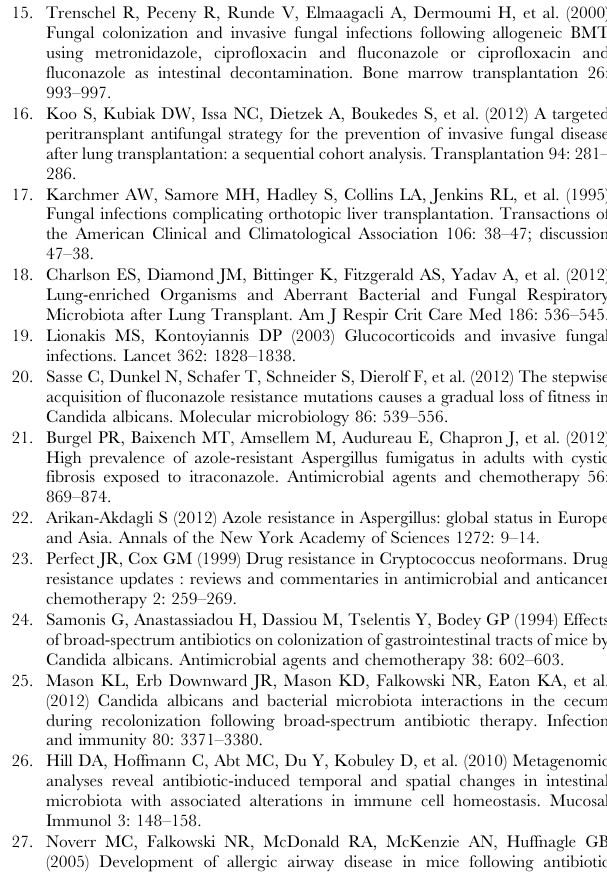
Table S4 Means, variances, and standard deviations for bacterial OTUs within treatment groups and time points rarefied to 200 reads per sample. Table S5 Means, variances, and standard deviations for fungal OTUs within treatment groups and time points rarefied to 200 reads per sample. Table S6 OTU table of bactieral 16S sequences rarefied to 200 reads per sample. Table S7 OTU table of fungal ITS sequences rarefied to 200 reads per